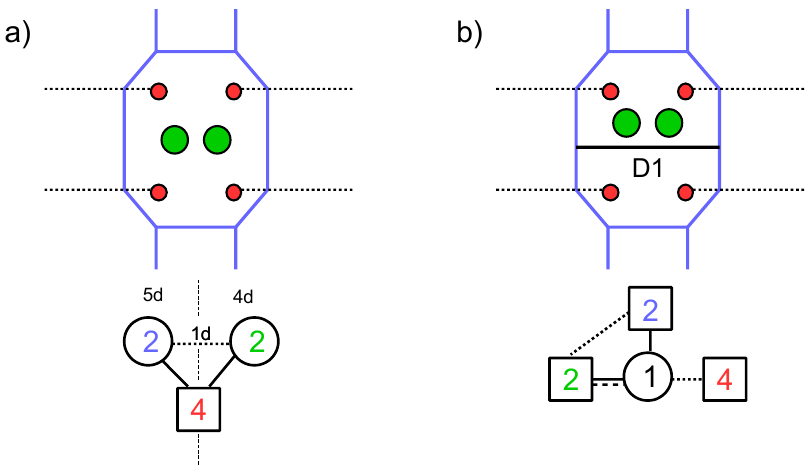
Figure 17 . a) Brane setup of 5d U(2) N f = 4 coupled to 4d U(2) N f = 4 through 1d Fermi mul- tiplets. b) 1-instanton sector of the theory and corresponding ADHM N = (0 ; 4) (cid:3) SQM (5d and